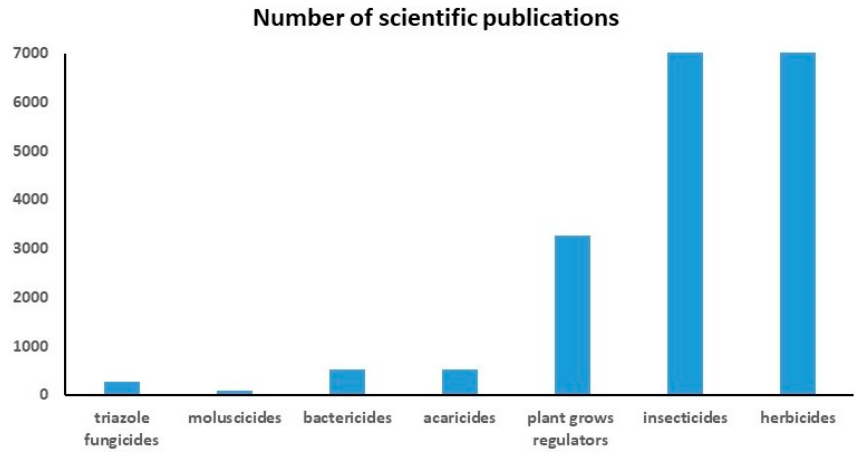
Figure 2. Number of scientific publications regarding the environmental effects of various pesticides found in the “Environment” section in the SpringerLink online collection in April 2021 (https://link-springer-com.am.e-nformation.ro/search?facet-discipline=%22Environment%22, accessed on 15 April 2021).